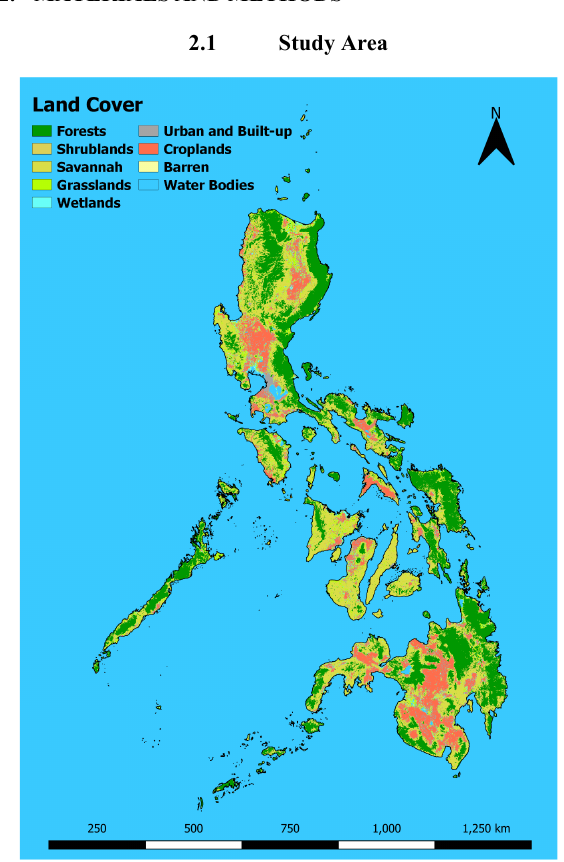
Figure 1. Land Cover Map of the